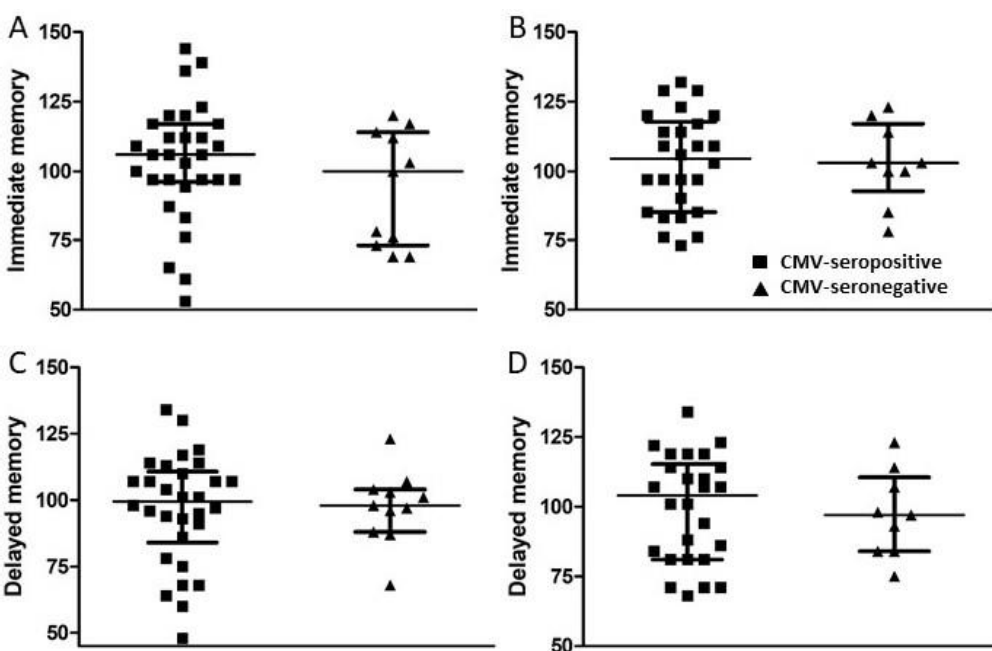
Figure 5. Comparison of immediate and delayed memory scores between groups of CMV-seropositive and -seronegative subjects at t1 and t2. ( A , C ) Following neuropsychological testing, immediate and delayed memory scores were calculated at t1 for all study subjects and ( B , D ) approximately 18 months later (t2) for all study subjects completing follow-up. Error bars on graphs show median ± interquartile range for each group. No significant differences between CMV-seropositive and -seronegative groups were observed. Mann – Whitney U -test, ( A ) p = 0.353, ( B ) p = 0.940, ( C ) p = 0.871, ( D ) p = 0.777.